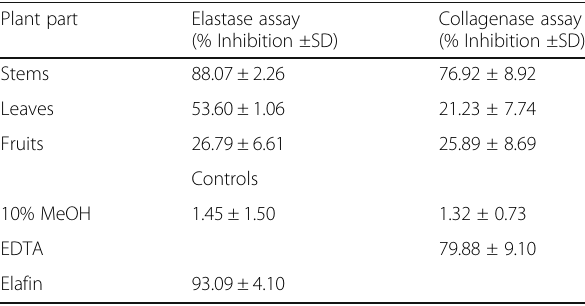
Table 1 Comparison of inhibition of the elastase and collagenase for extracts of different parts of S.